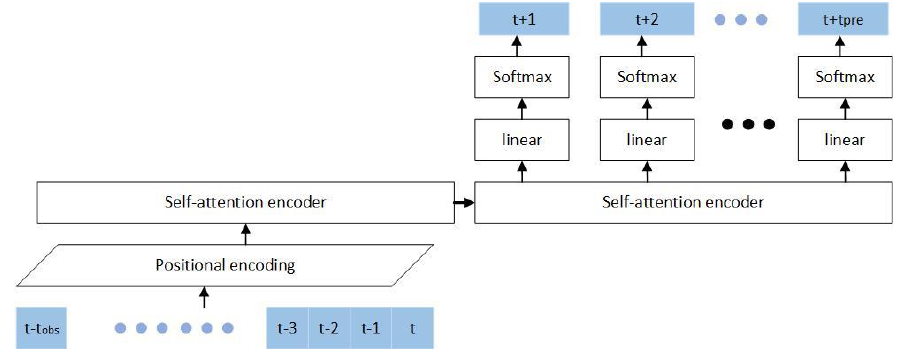
Figure 3. The structure of the VC-Attention.